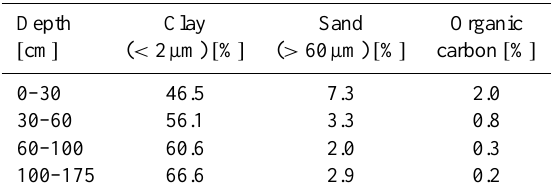
Table 1. Clay, sand and organic carbon content of the field site in Lanna (from Bergström et al., 1994). The upper horizon is consid- ered to be topsoil and the rest of the soil profile is considered to be